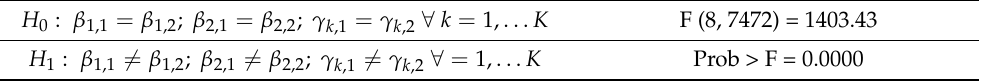
Table 11. Chow Test Results.